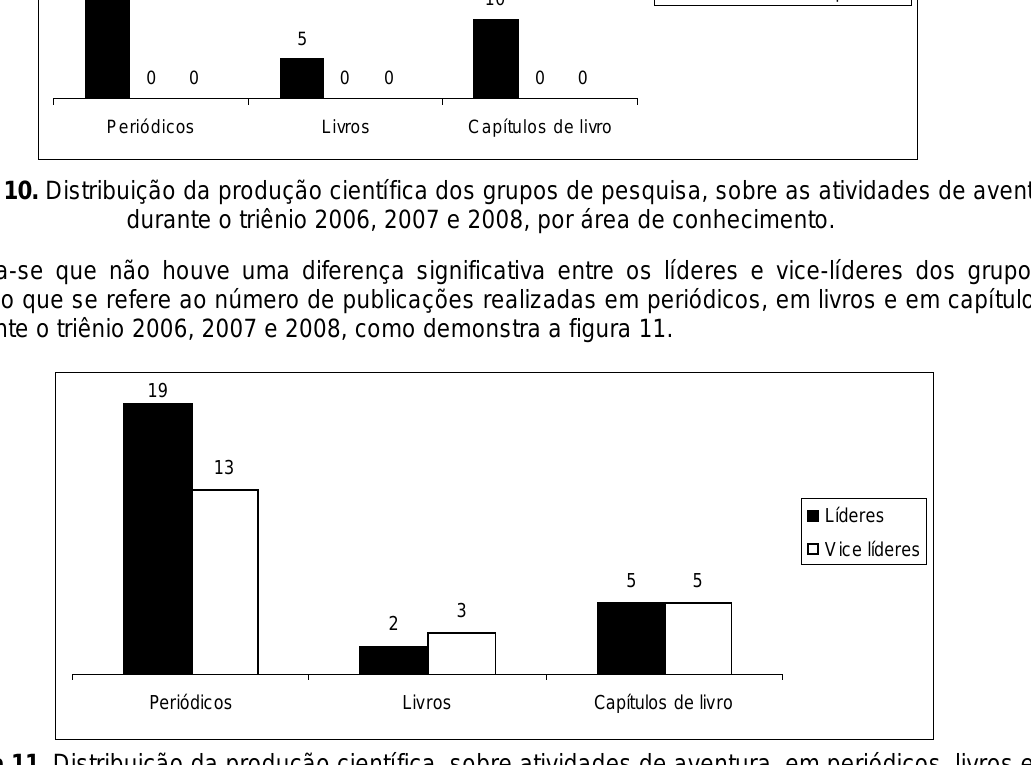
Figura 11. Distribuição da produção científica, sobre atividades de aventura, em periódicos, livros e capítulos de livros dos líderes e vice-líderes dos grupos de pesquisa. Na figura 12, é possível observar o número total de publicações dos 23 grupos de pesquisa encontrados no Diretório.